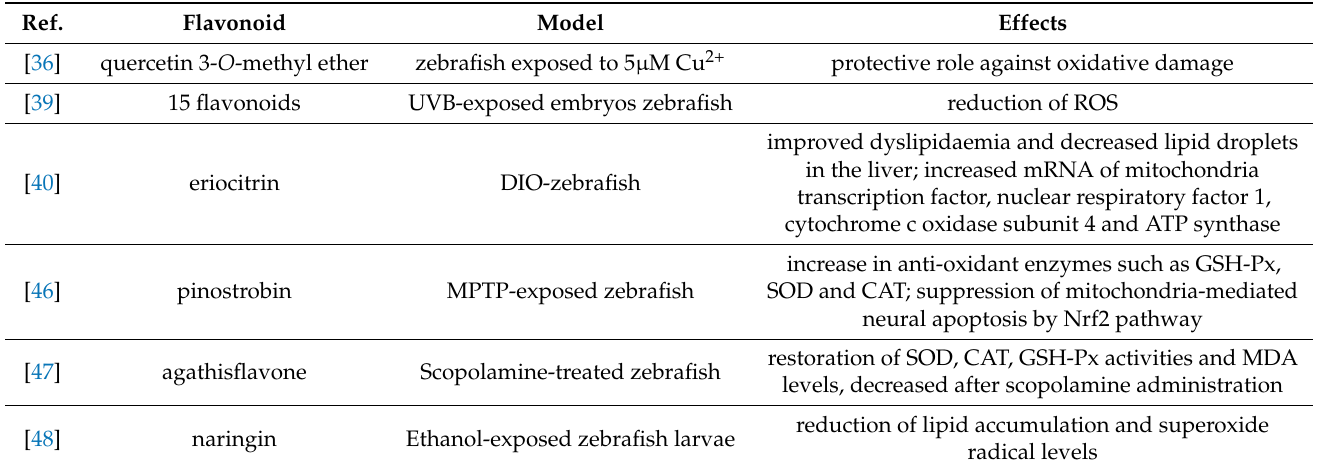
Table 1. Studies employing zebrafish to assess the antioxidant activity of flavonoids.